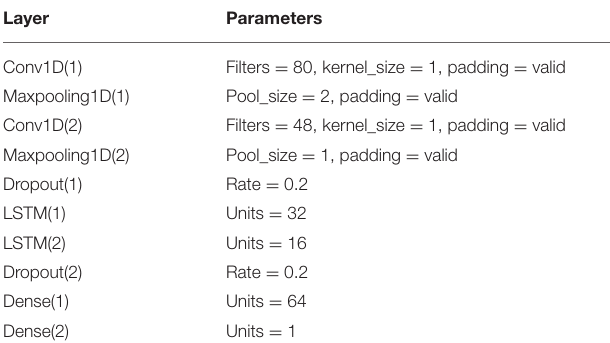
TABLE 2 | Parameters of each layer of the CNN-LSTM model.